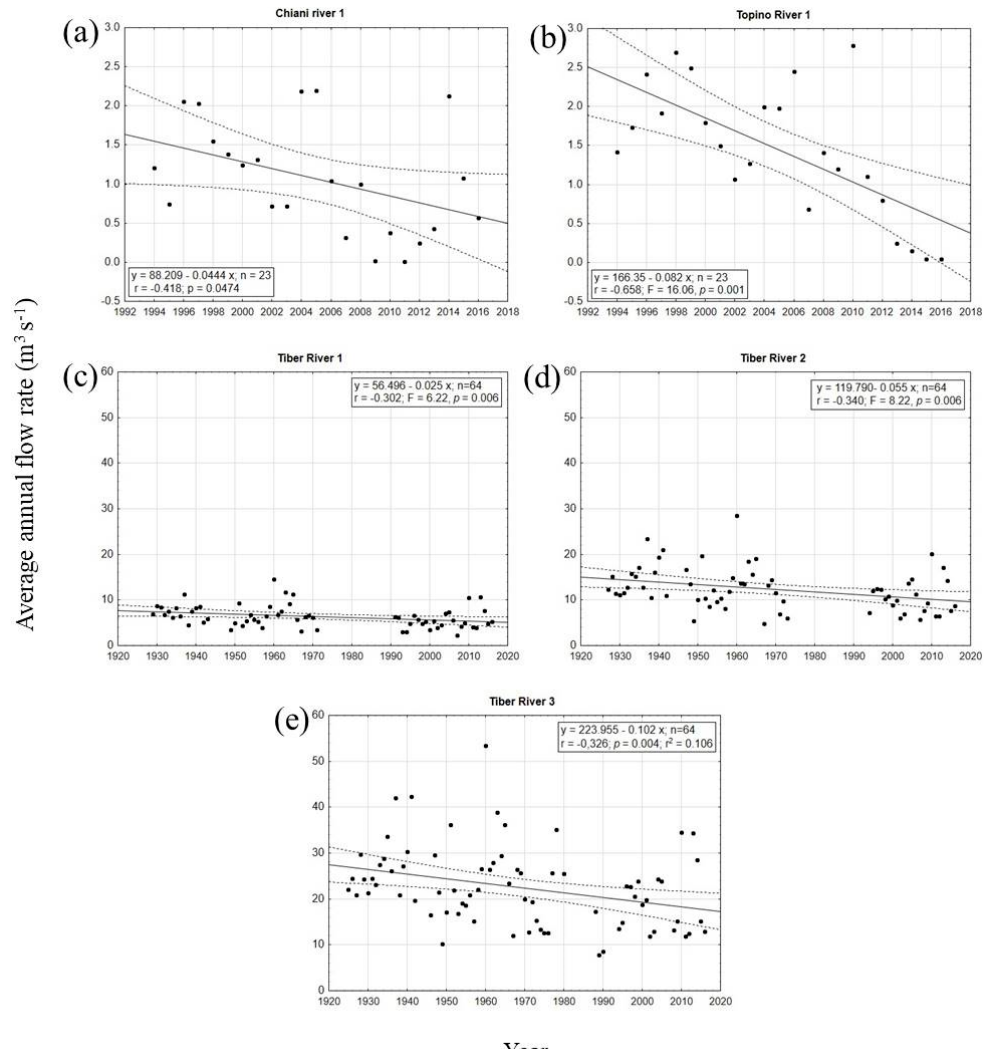
Figure 3. Trend over time of the annual average flow rate for 5 hydrometric sites: Chiani River 1, Topino River 1, Tiber River 1, 2, 3. Time periods: ( a , b ) 1992–2016; ( c – e ), 1920–2016. Solid lines represent the linear regressions. Dashed lines represent the regression bands with 0.95 confidence intervals.